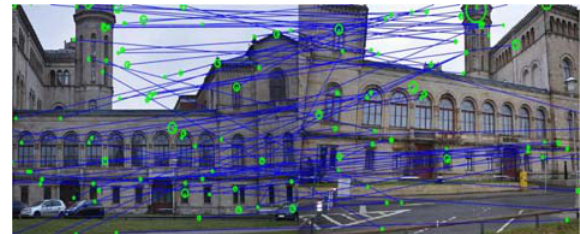
Figure 7. Mismatching of Hannover University.